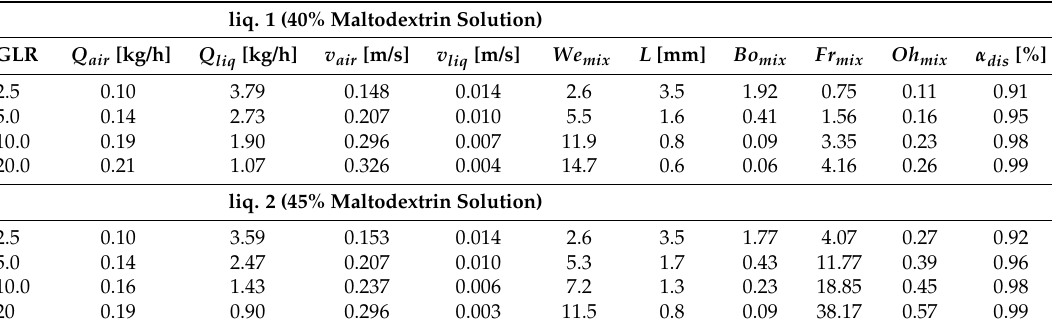
Table 2. Working parameters of the OIL nozle.